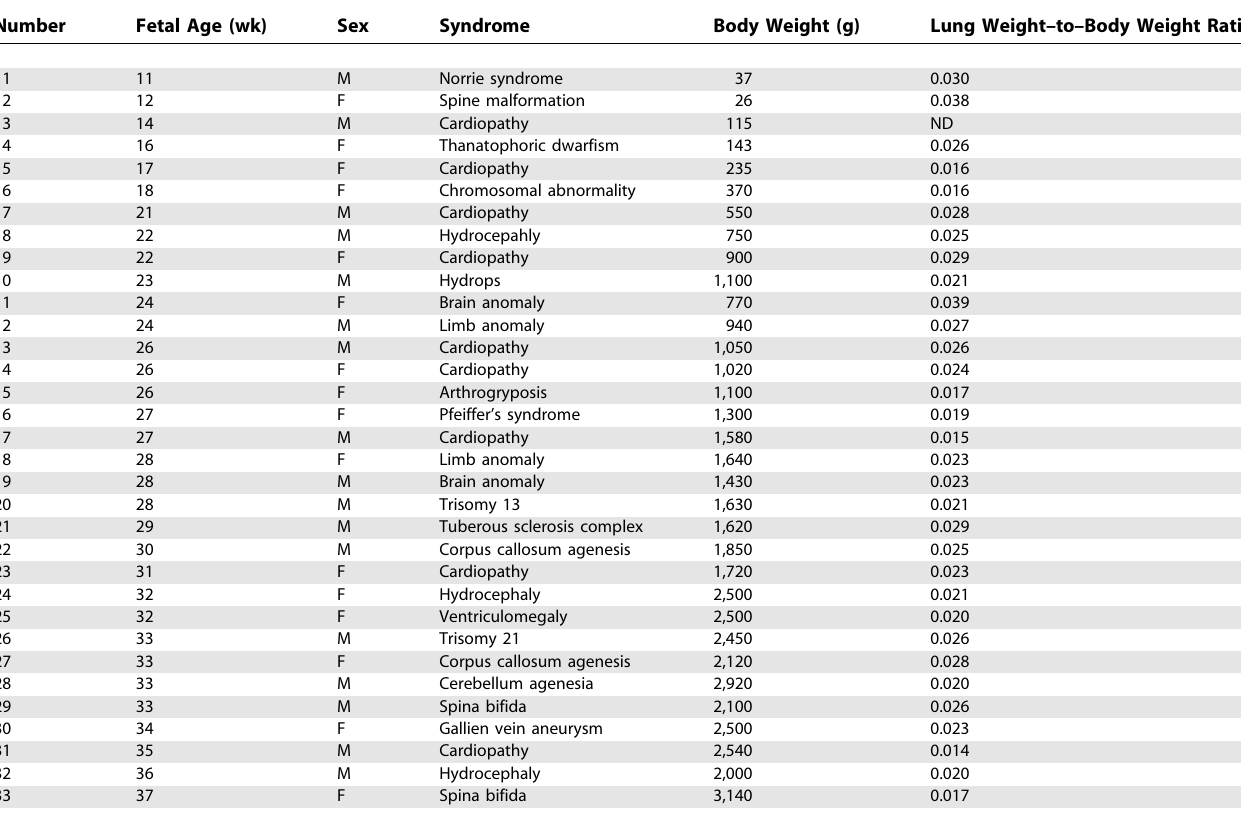
Table 2. Characteristics of Fetuses with Nonpulmonary Diseases Used as Controls Number Fetal Age (wk)